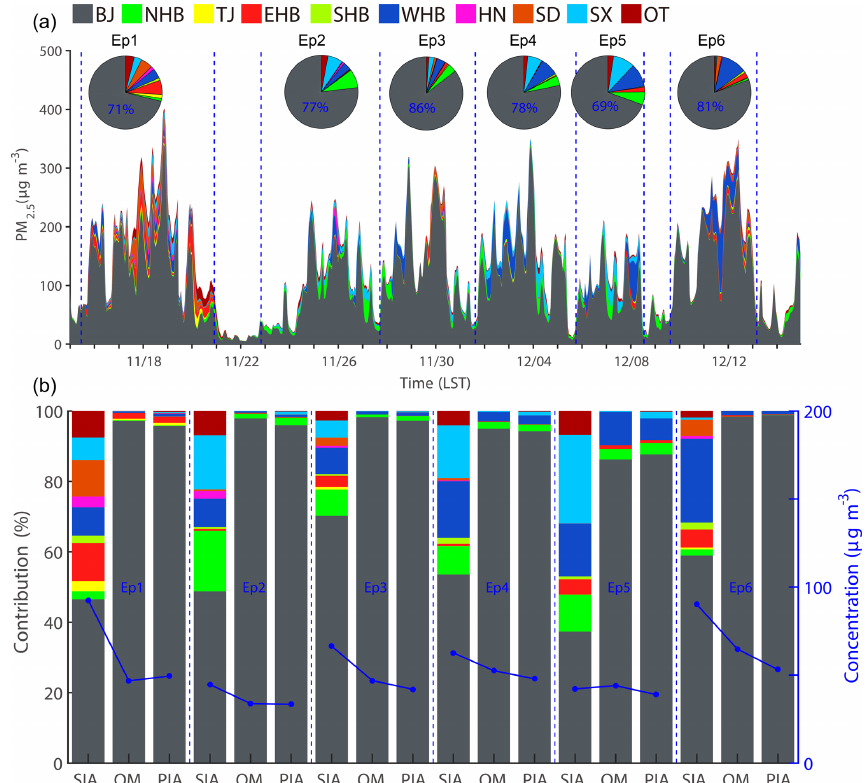
Figure 7. (a) Source contribution of PM 2 . 5 in Beijing; the pie charts represent the average status of each episode. (b) The relative contribution of different regions to SIA, OM, and PIA in Beijing at the surface layer during each episode (shaded). The concentrations are also shown (blue